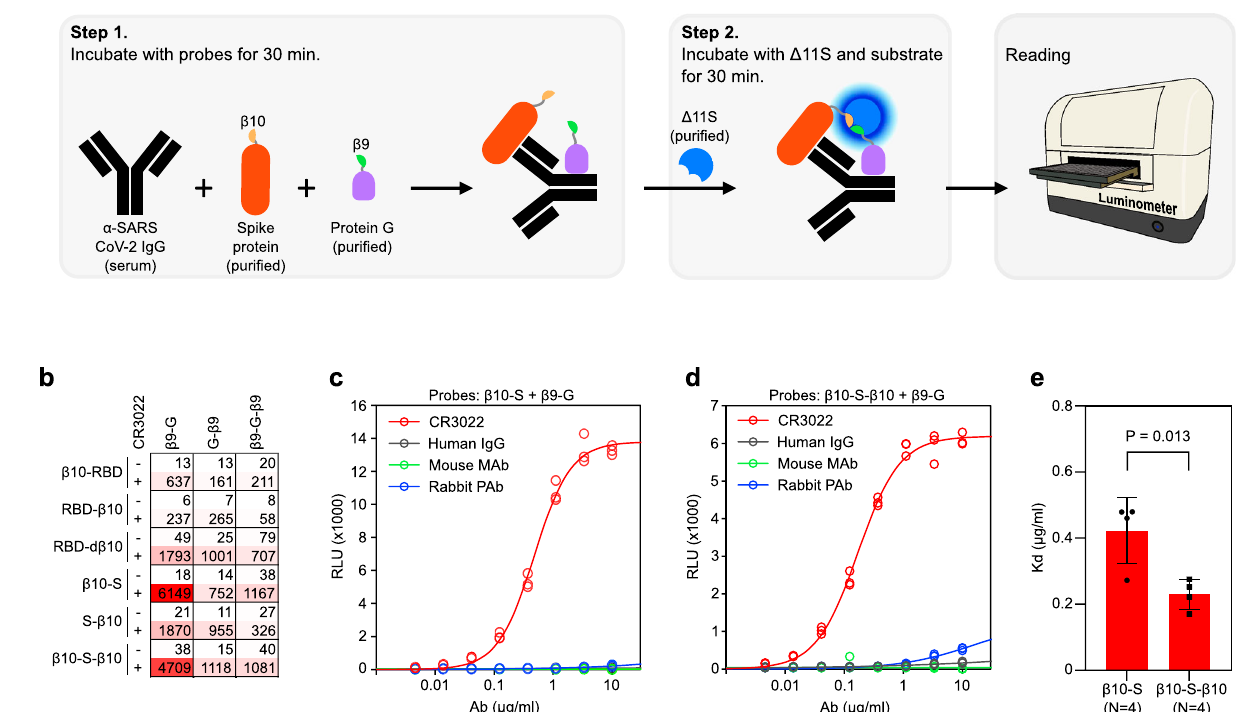
Fig. 1 tNLuc-based SATiN assay for detecting α -SARS-CoV-2 antibody. a Schematic work fl ow of the SATiN assay. b Scan of all probe formats/ combinations in the SATiN assay using CR3022 Ab (2 µ g/mL). Results are presented as a heatmap showing RLU values. Data shown here are a representative result of three independent experiments with similar results. c , d CR3022 (red) at different concentrations was tested with β 9-G together with β 10-S ( c ) or β 10-S- β 10 ( d ) probes. Human IgG (gray), a mouse monoclonal Ab (green), and rabbit polyclonal Abs (blue) were used as controls. Data shown here are a representative result of four independent experiments for each probe with similar results . e Comparison of β 10-S and β 10-S- β 10 af fi nities in the SATiN system. The average K d values of four independent experiments for each probe are presented as mean ± SD. P -value was calculated using a two-tailed t -test. Source data are available in the Source Data fi